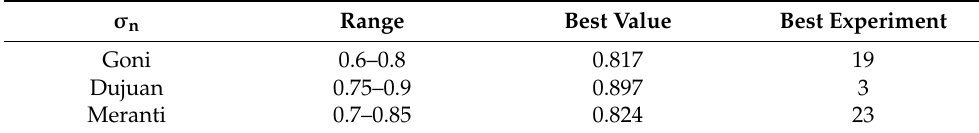
Table 6. σ n statistics of the wind speed simulation in the three typhoon events.